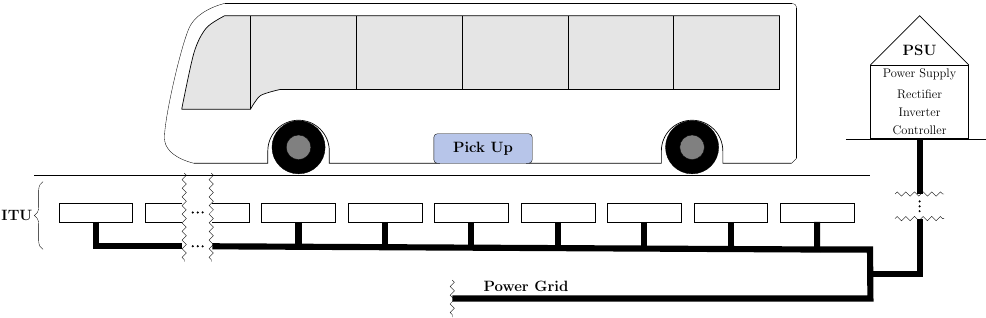
Figure 5. Components of the power transmitter system.